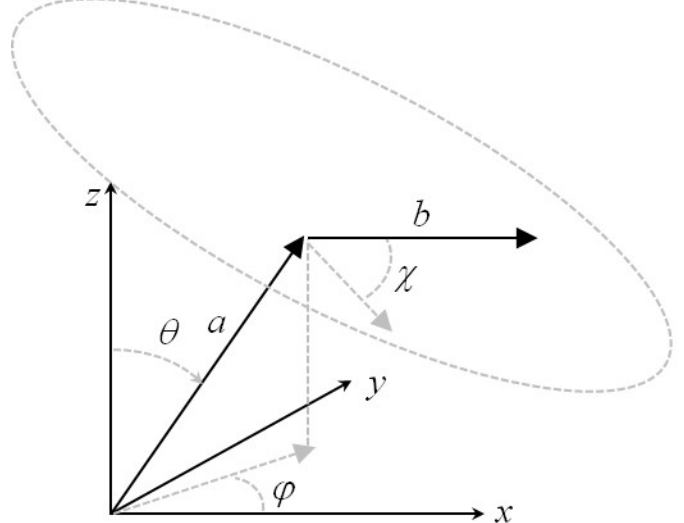
Figure 2. Definitions of angles used to describe directions in calculations.